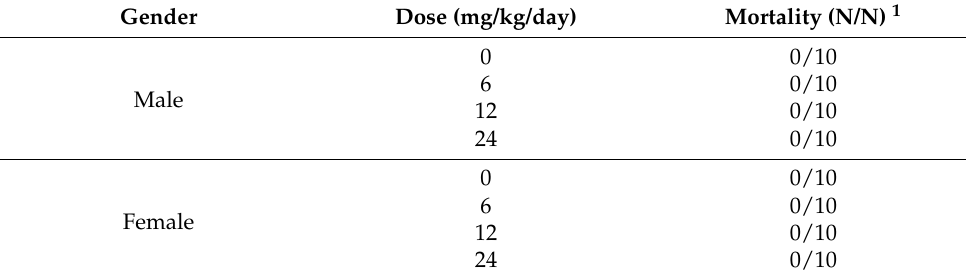
Table 2. Mortality of rats receiving astaxanthin over a 13-week